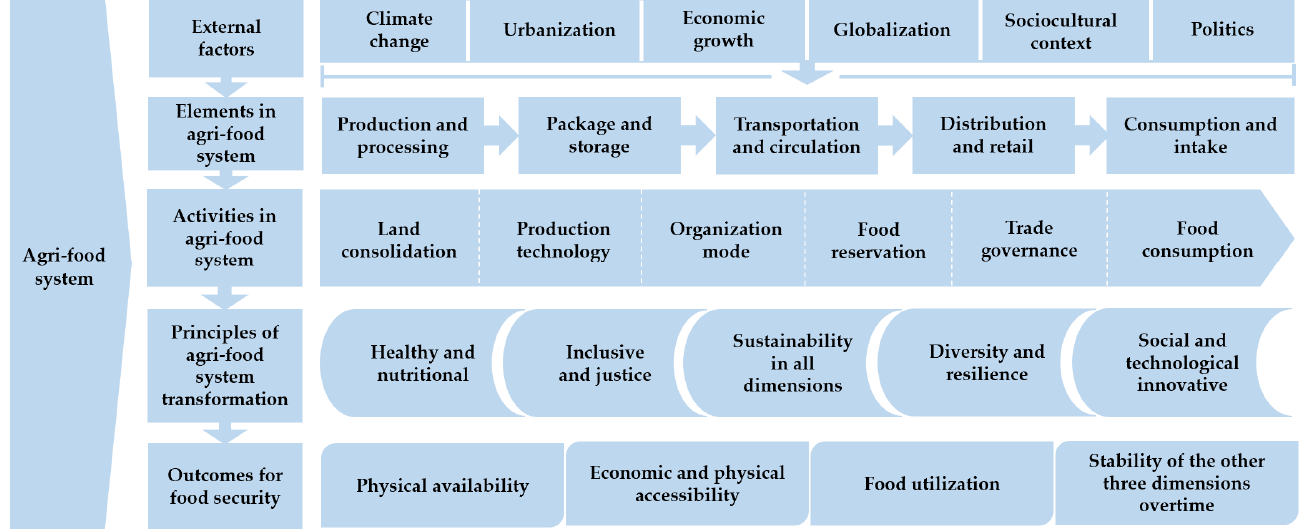
Figure 1. Research